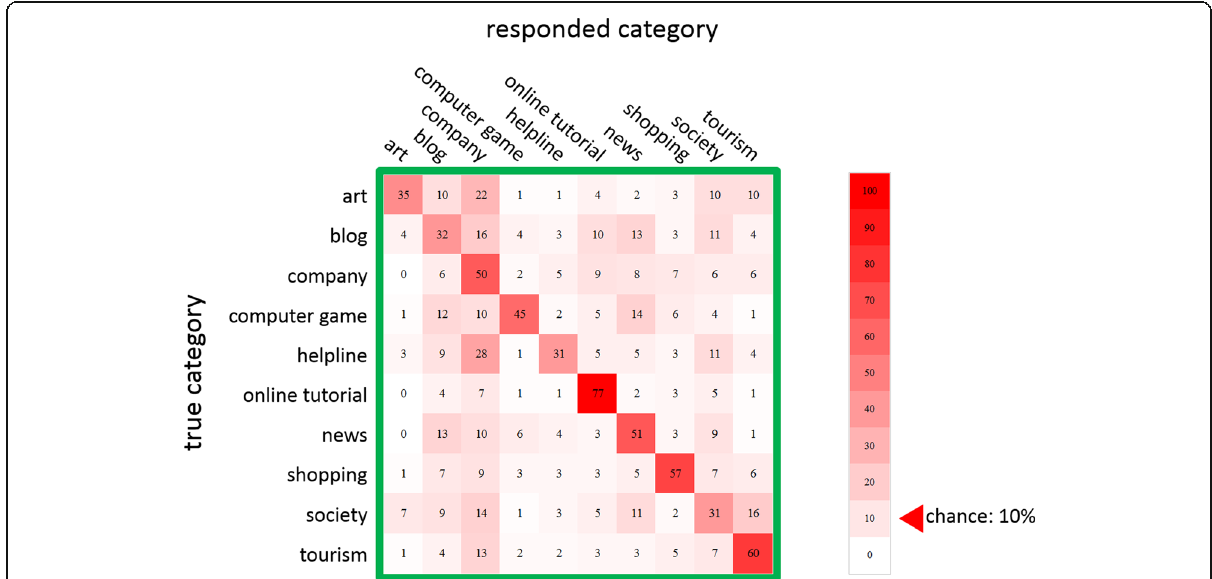
Fig. 3 Results of the gist experiment. Each row denotes the correct category of a given figure, and each column the responded category. The value in each cell is the percentage of trials which, for each true category (row label), the screenshot was identified as the category given by the column label. Values along the diagonal indicate the percentage of correct responses per category